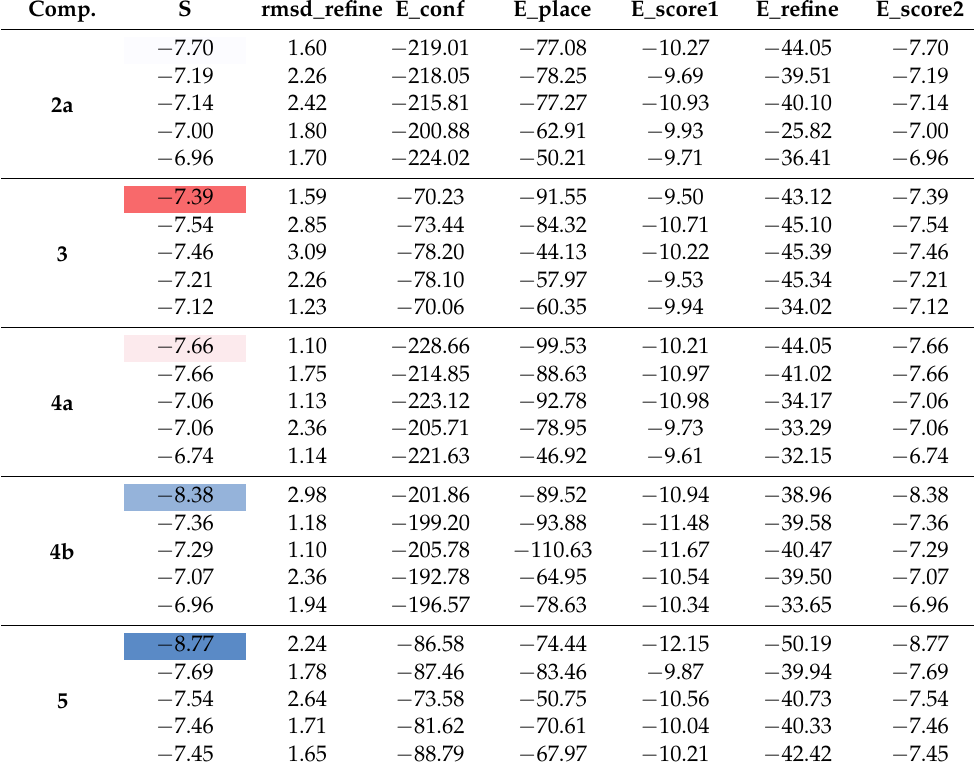
Table 5. Docking score and energies of all compounds with ovarian “ 3 W2S ” protein.